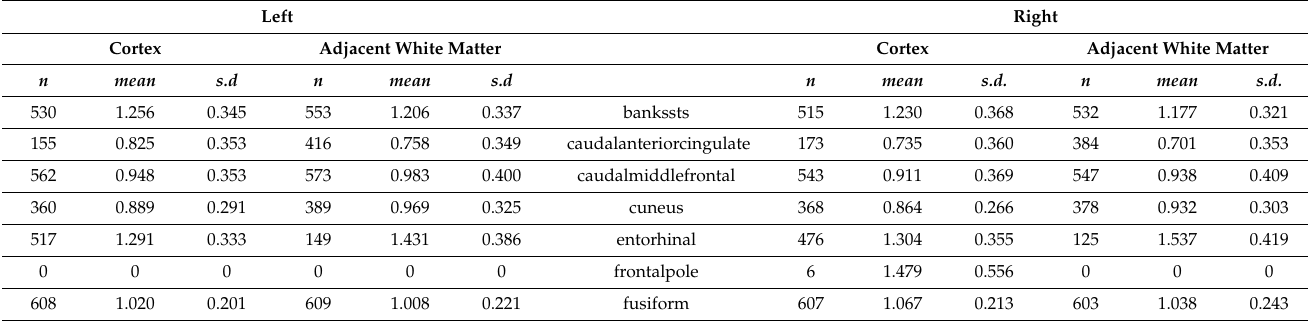
Table A1. Atlas for measures with random forest empty-room correction. Regional measures of neuroelectric activity for 68 cortical and 68 adjacent white matter regions were extracted from both the baseline ( n = 613) CamCAN recordings. The columns labelled “ mean ” and “ s.d. ” contain the means and standard deviations for the baseline current density measures These density measures were transformed to z-scores . The columns labelled “ n ” show the number of subjects for whom the random forest classification yielded significant accuracy for resting vs. empty-room recordings. Only those subjects’ measures were used to compute the densities listed in the